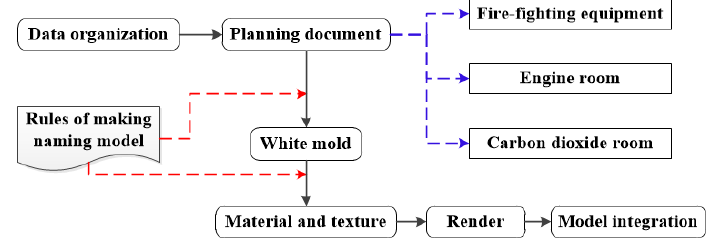
Figure 2. Modeling